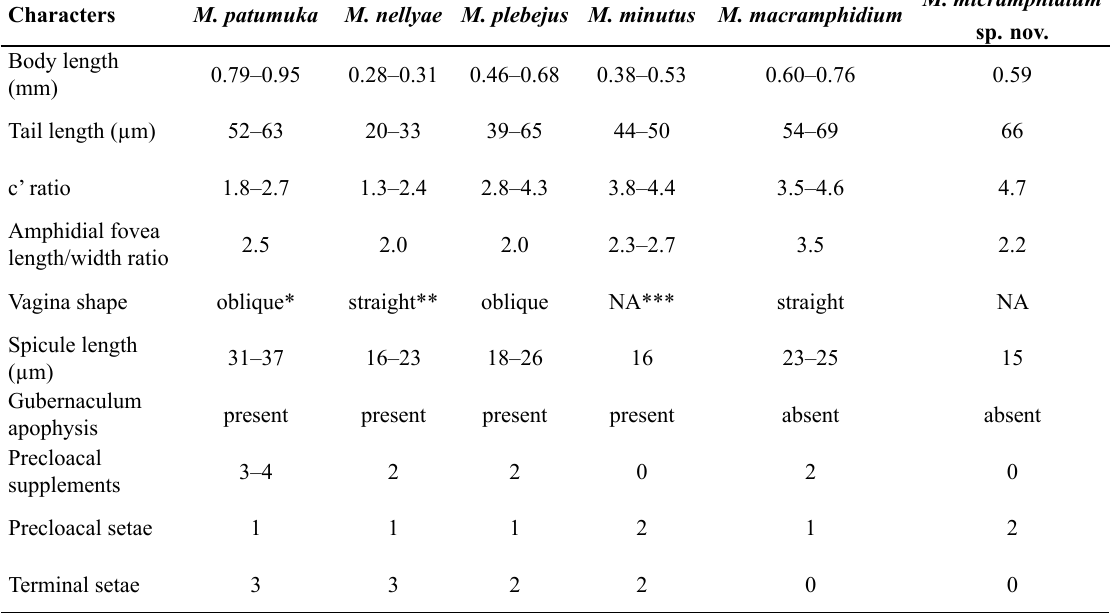
Table 2. Selected diagnostic characters of species of the genus Mudwigglus Leduc, 2013 based on literature data supplemented with recent